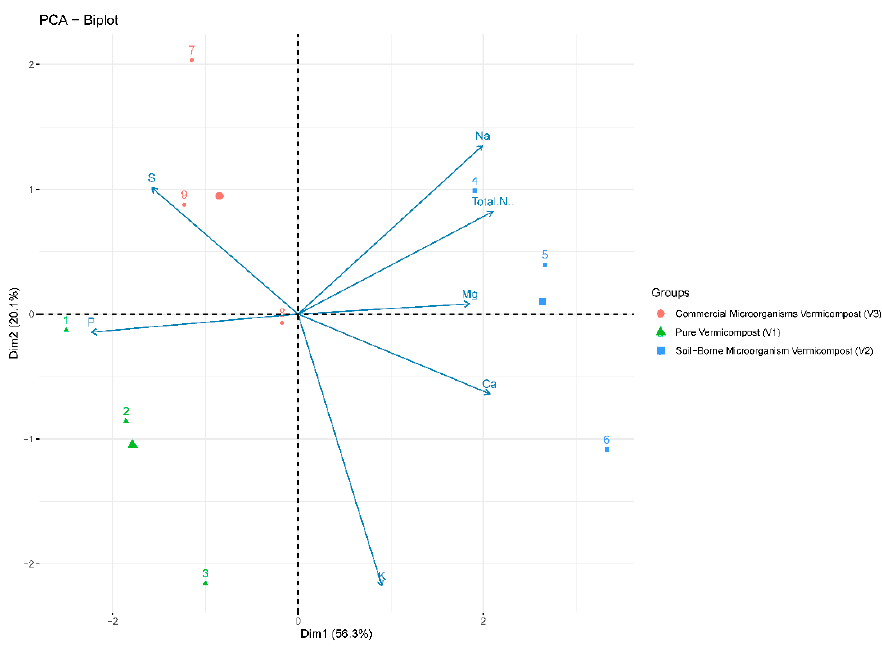
Figure 3. PCA of the macronutrients of the three vermicompost formulations. 1: vermicompost without inoculation (V1); 2: soilborne vermicompost (V2); 3: commercial vermicompost (V3).